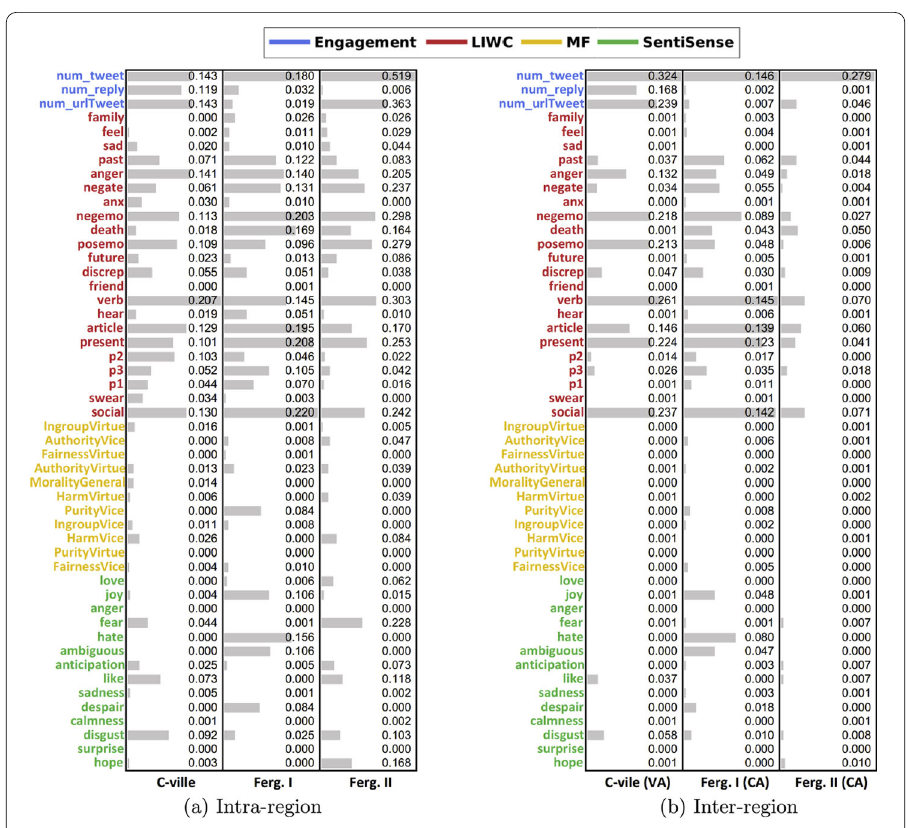
Figure 6 Mean absolute values of intra-region and inter-region input (gate) weights. These are the input weights learned from the neural network model (the LSTM networks in the temporal and spatial components) and the magnitude of weights (which can take any values) allows for a comparison of the relative importance of different features. ( a ) Intra-region input weights. ( b ) Inter-region input